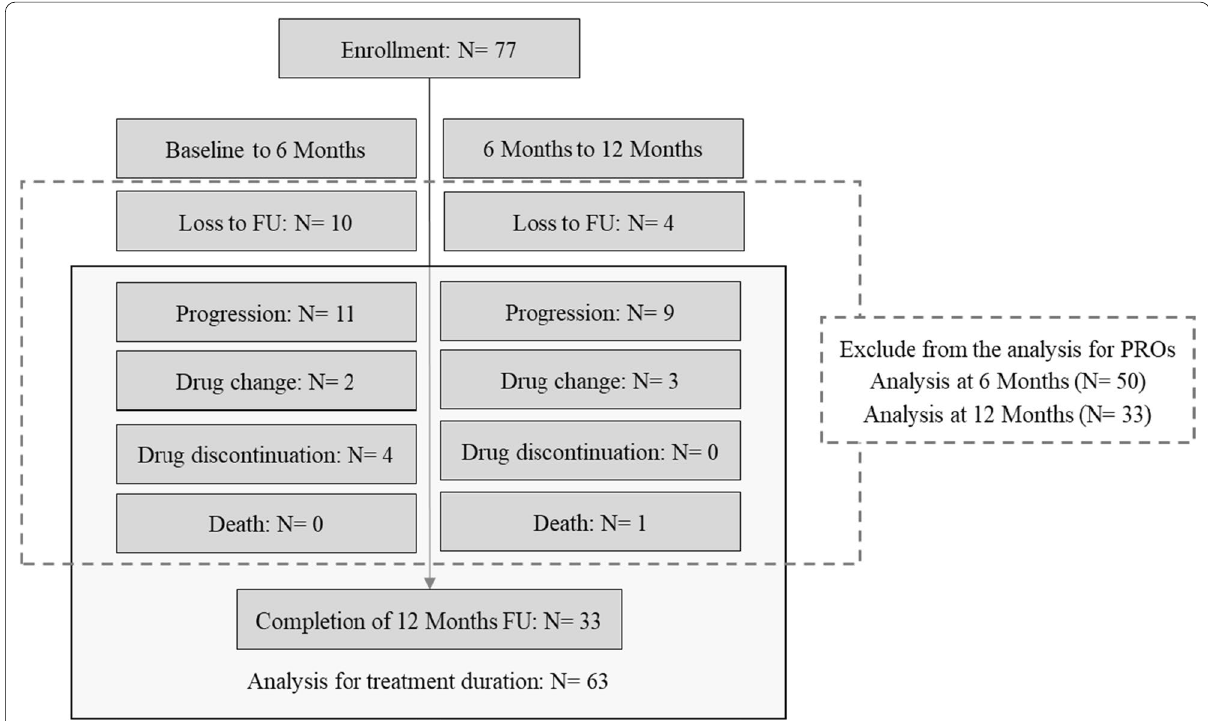
Fig. 1 Flow chart of patient numbers included in each